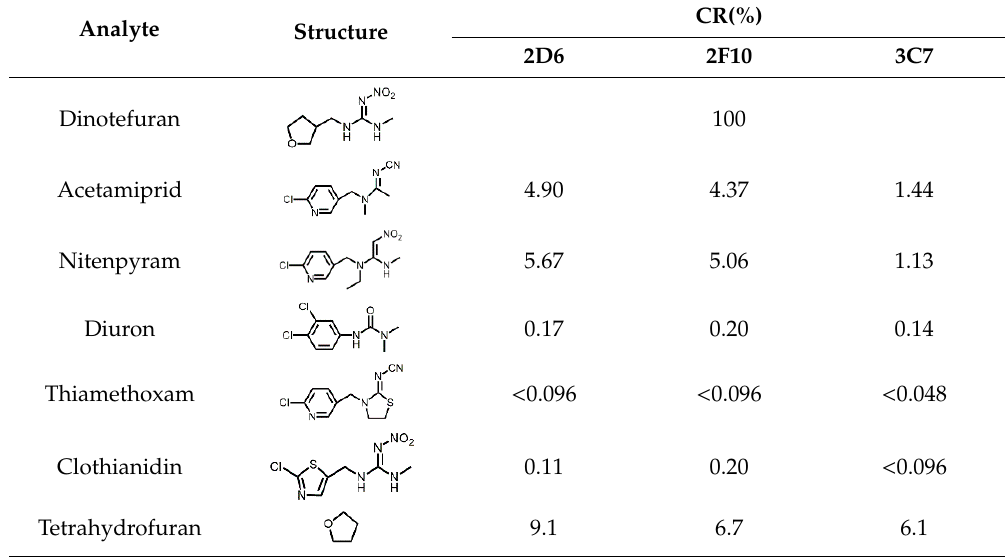
Table 2. Cross-reactivities (CRs) of the antibody to the analytes.